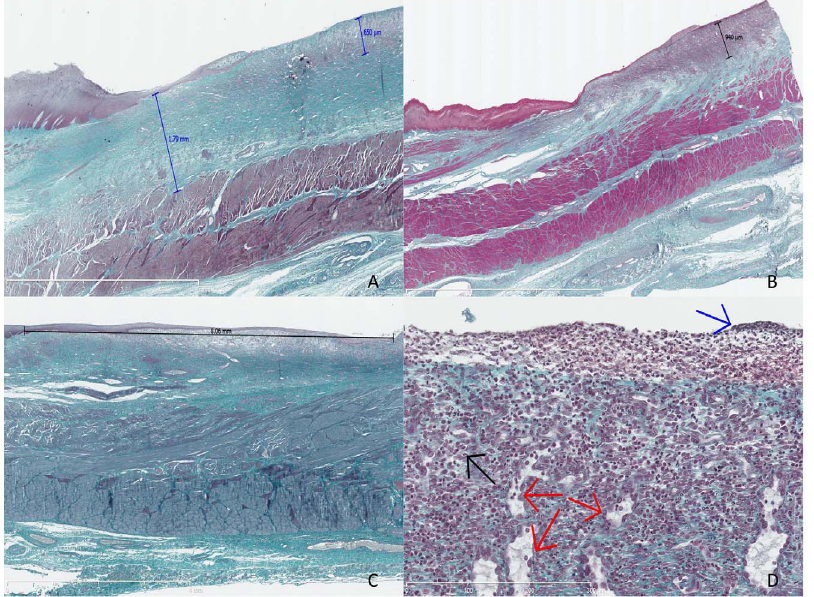
Figure 3. Histological analysis of the swine esophagus after Masson’s trichrome staining. A: swine from the control group, sacrificed at day 14, with major fibrosis measured at 1.79 mm and thick granulation tissue measured at 0.65 mm, original magnification 12.5x; B: swine from the AM 1 group (amniotic membrane graft and early sacrifice scheduled at day 14), without esophageal stricture, with minimal fibrosis and mostly granulation tissue, measured at 0.94 mm, original magnification 10x; C: swine from the AM 2 group sacrificed at day 21, exhibiting major re- epithelialization measured at 8.06 mm, original magnification 15x; D: granulation tissue with features of acute inflammation, as observed in the early phase of esophageal wounds: high cell density, predominance of polynuclear cells (black arrow), fibrino-leucocytary network (blue arrow), and typical palissadic vascular growth (red arrows), original magnification 400x. doi:10.1371/journal.pone.0100236.g003 PLOS ONE |